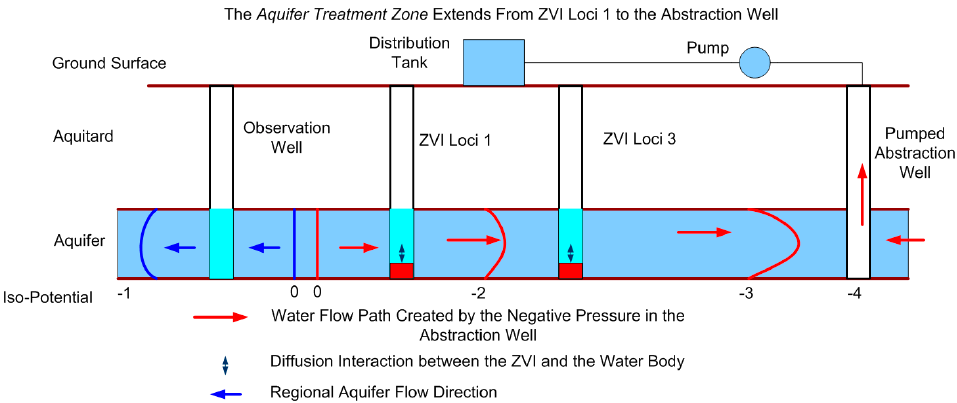
Figure C2. Cross section through a schematic aquifer which has been reconfigured to produce partially desalinated water. ZVI pellets and cartridges are shown in red.